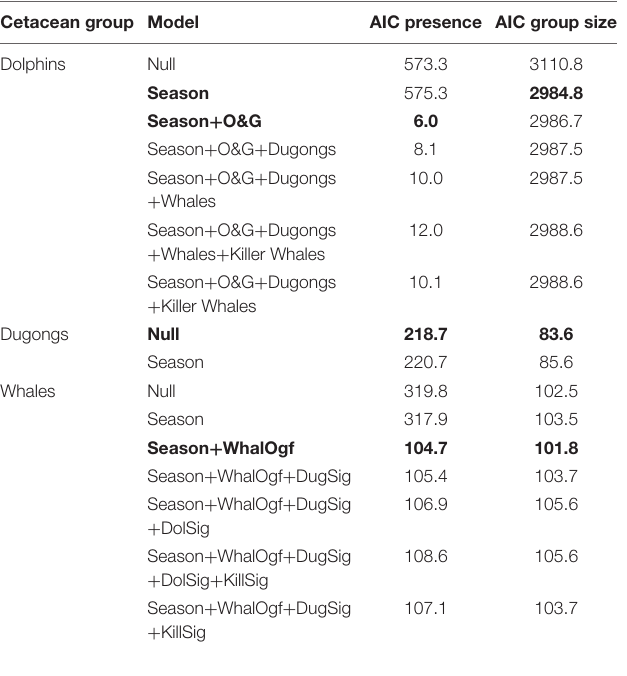
TABLE 1 | Best supported model (in bold) for observations of dolphins, dugong and whales by fishermen as absence/presence data and as group size conditions on presence.